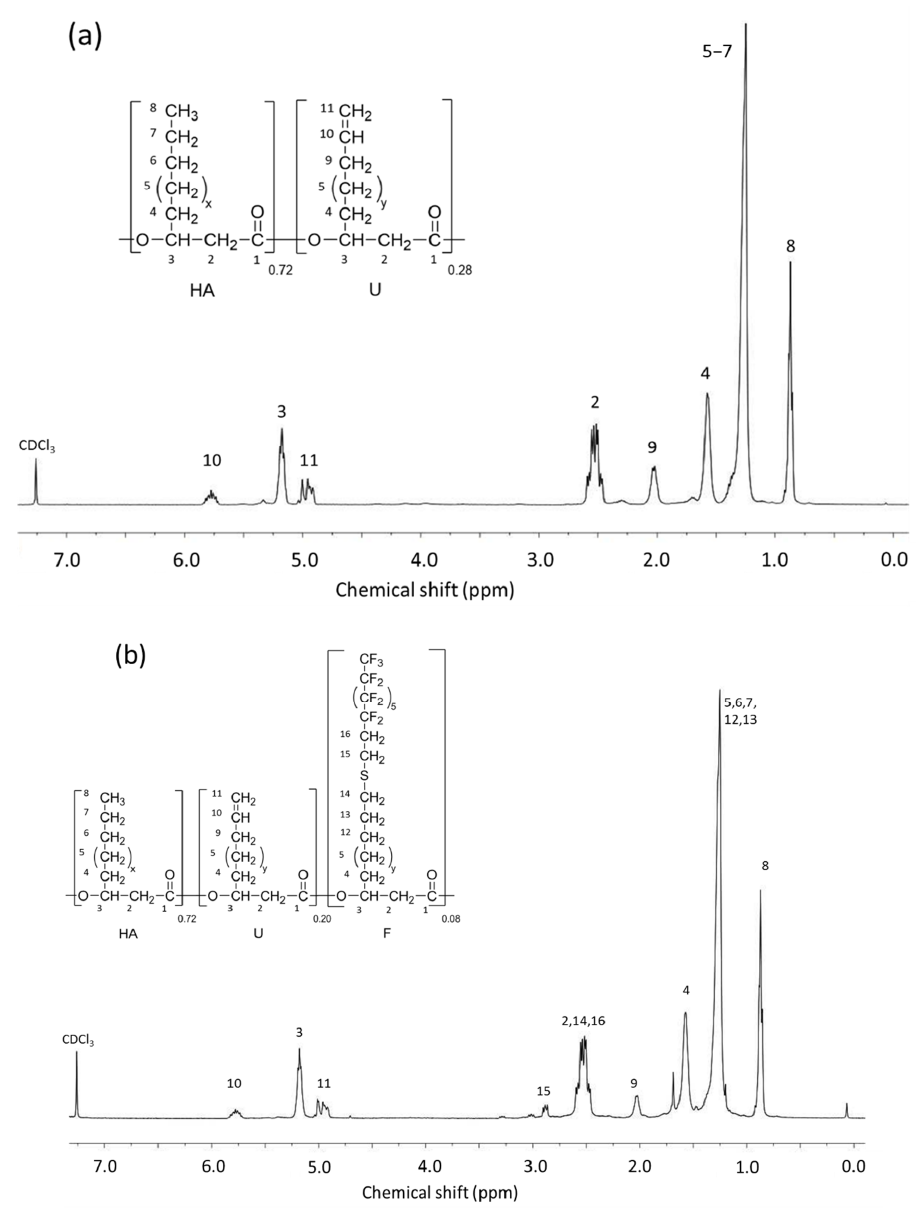
Figure 4. 1 H NMR spectra in CDCl 3 . ( a ) PHAU; ( b ) PHAU-g-C 8 F 17 . (x: 1,3,5; y: 2,4).